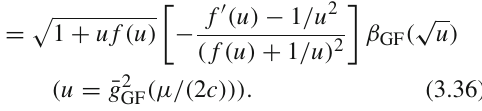
Fig. 4 The determination of (cid:3)